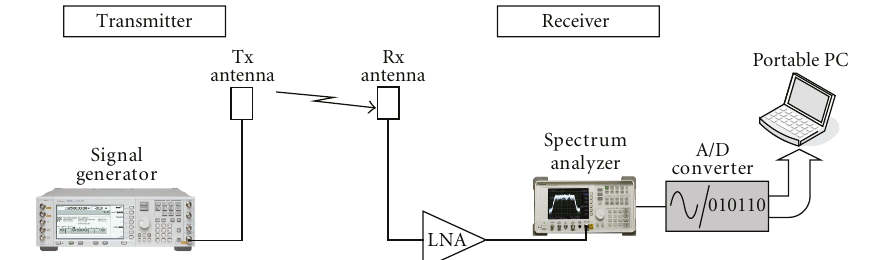
Figure 3: Measurement system setup.